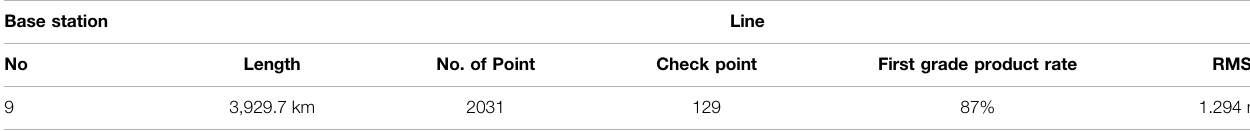
TABLE 1 | Summary of magnetic